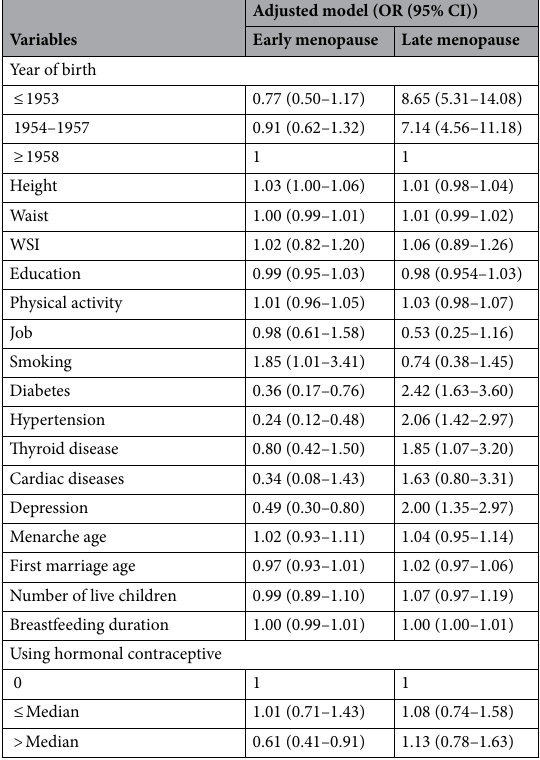
Table 3. The association of early and late menopause with the selected variables using multinomial logistics regression model. The adjusted model is adjusted for confounding variables: year of birth (categorical variable), height (continuous variable), waist (continuous variable), wealth status index (continuous variable), education years (continuous variable), physical activity level (continuous variable), has job (yes, no), cigarette smoking(yes/no), diabetes (yes/no), hypertension (yes/no), thyroid disease (yes/no), cardiac diseases (yes/no), depression (yes/no), menarche age (continuous variable), first marriage age (continuous variable), number of live children (continuous variable), breastfeeding duration (continuous variable) and using hormonal contraceptive